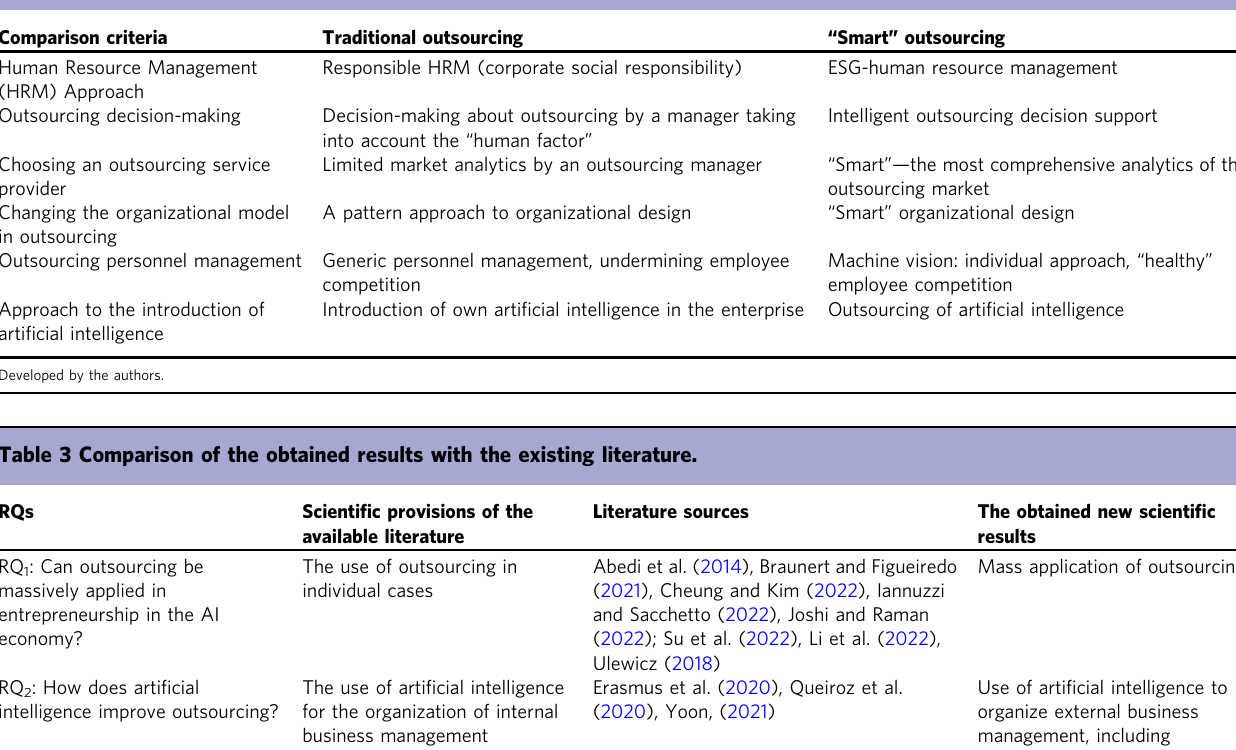
Table 2 Comparative analysis of traditional and “ smart ” outsourcing in terms of contribution to the humanization of entrepreneurship.